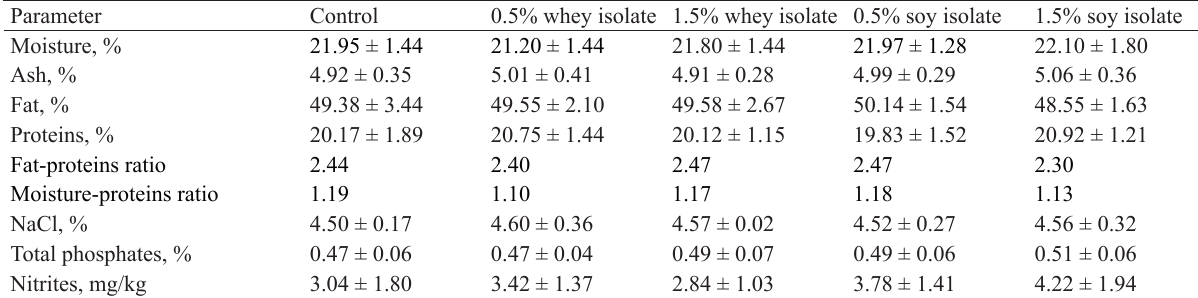
Table 1 Chemical composition of sausages with protein isolates (average value ± SD) Parameter